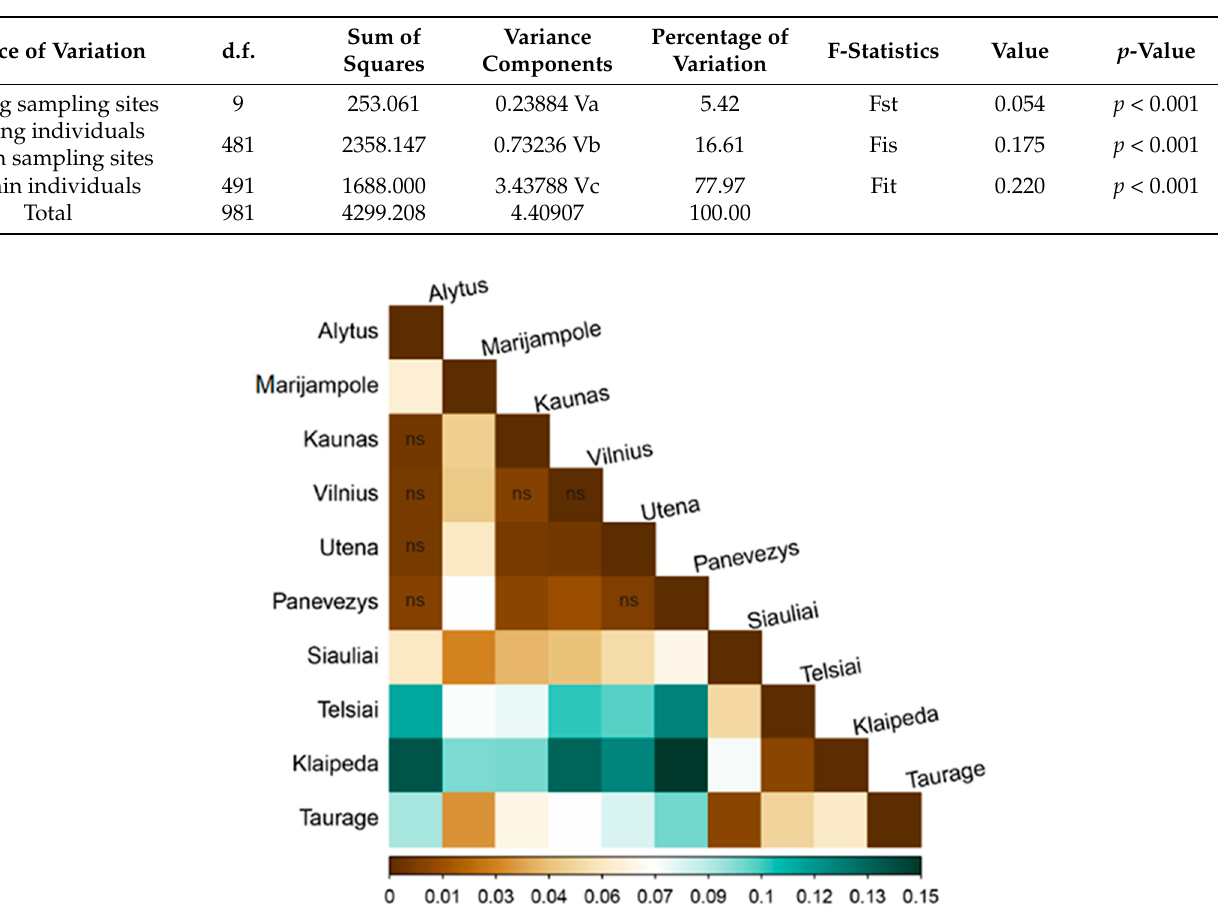
Table 3. Analysis of molecular variance (AMOVA) results for sampling sites of wild boar based on various genetic groupings.